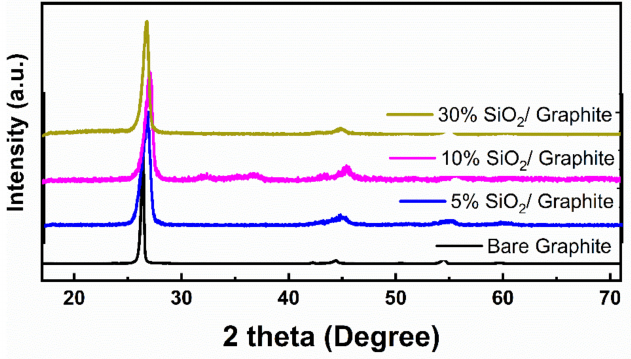
Figure 4. Electrochemical performance of SiO 2 in the NCA